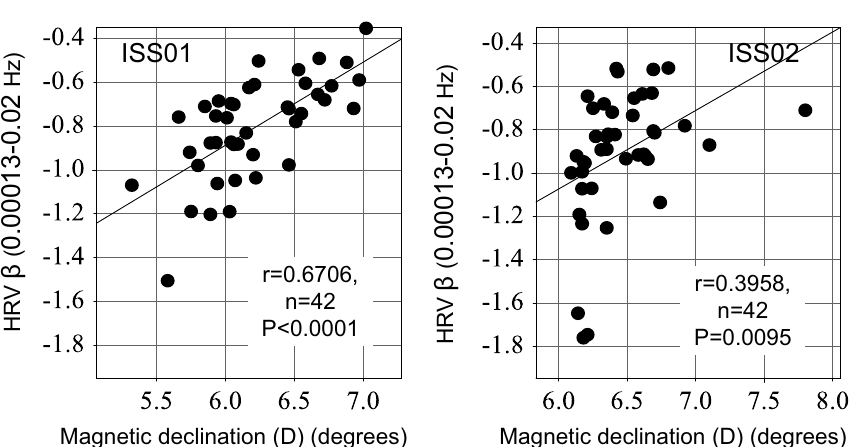
Figure 1. Effects of magnetic fluctuations on the “intrinsic” cardiovascular regulatory system (β). Magnetic declination (D) correlates positively and statistically significantly with the “intrinsic” cardiovascular regulatory system (β) during both ISS01 (r = 0.6706, P < 0.0001) and ISS02 (r = 0.3958, P = 0.0095). These results suggest that the improvement in β may relate to magnetic fluctuations in space, and that the effect may last during the entire 12-month spaceflight. Pearson’s correlation coefficients computed from hourly averages of magnetic declination (D) and HRV β in order to eliminate or at least reduce serial